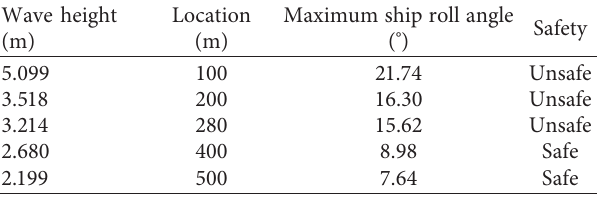
Table 5: Relationship between the wave height and the maximum roll angle.